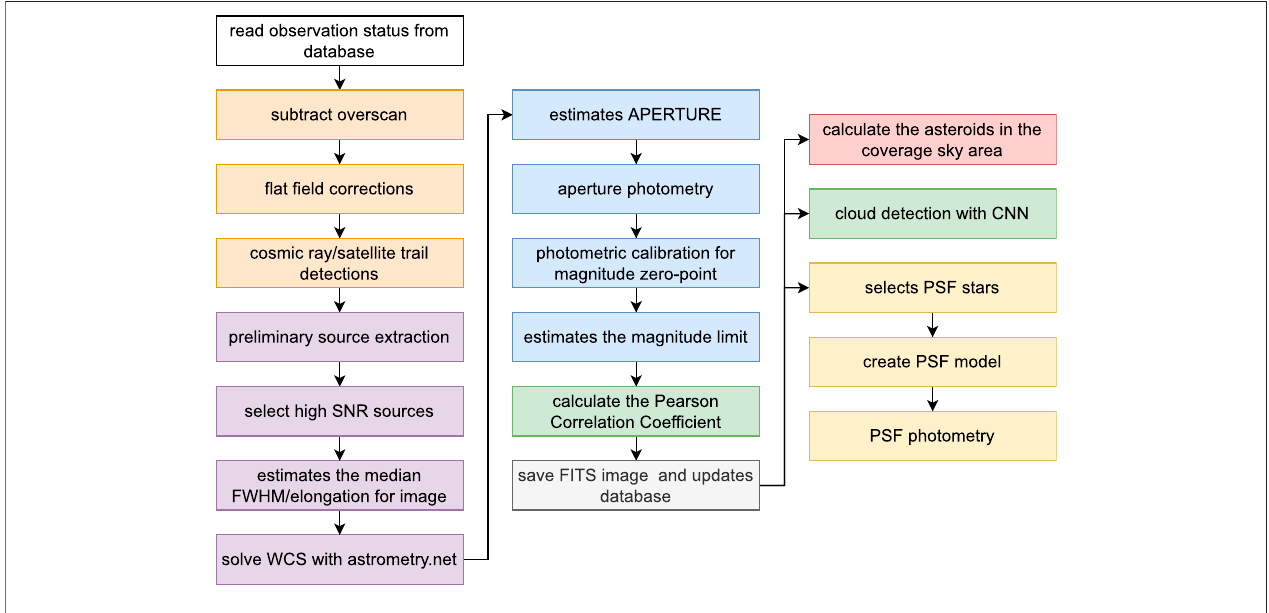
FIGURE 1 | Flow of the single-frame image processing for